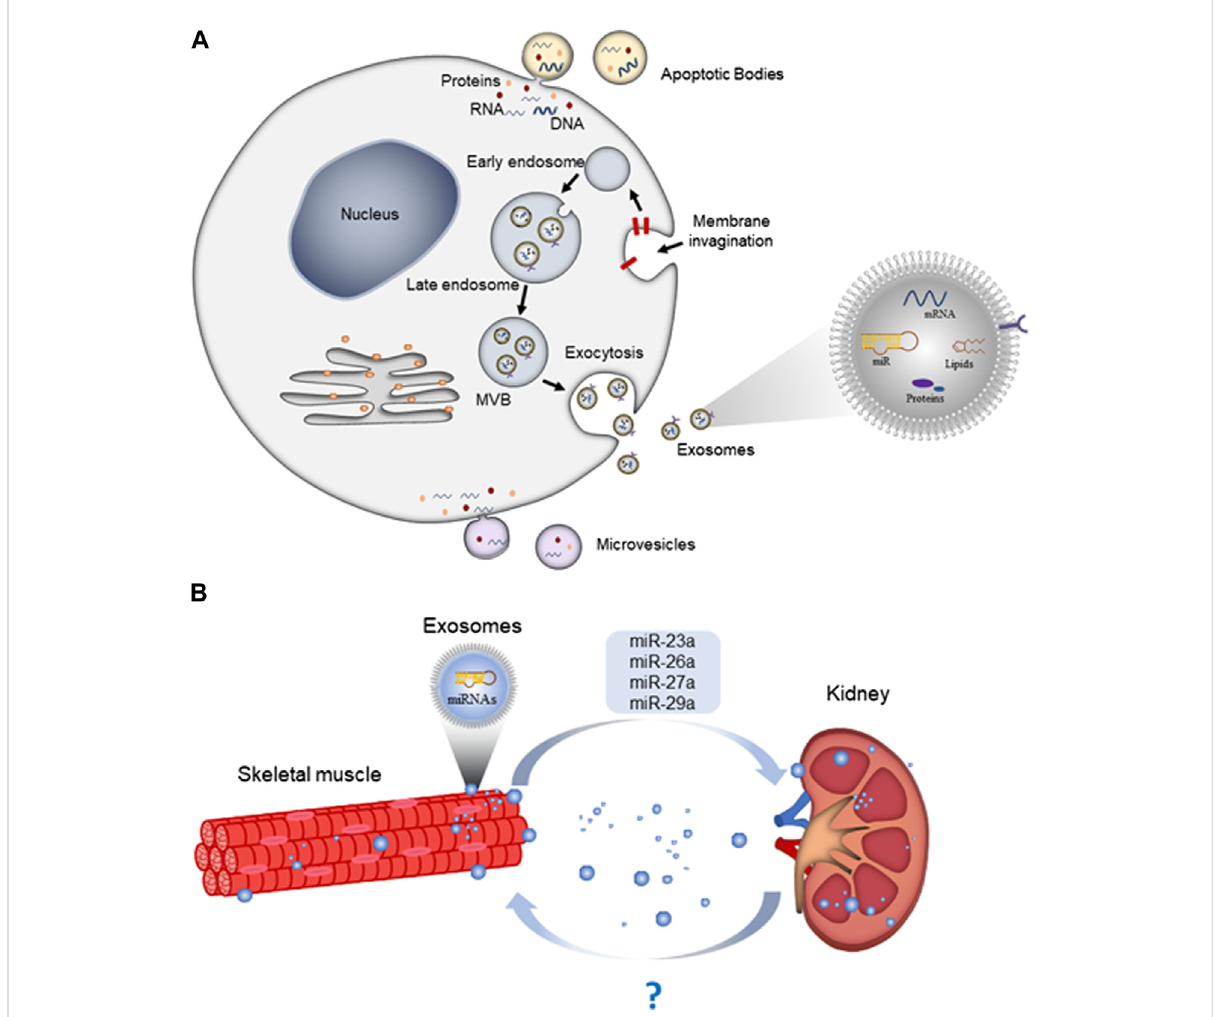
FIGURE 1 Exosome biogenesis, release, and as mediators for organ crosstalk. (A) Exosomes are formed by the endosomal system, including invagination of the endocytic membrane, early endosomes, late-endosomes, and multivesicular bodies (MVBs). Subsequently, large MVBs fuse with the cellular plasma membrane and release exosomes into the extracellular space; (B) skeletal muscle-derived exosomes can travel along the circulation and deliver miRNAs to kidney and exert speci fi c